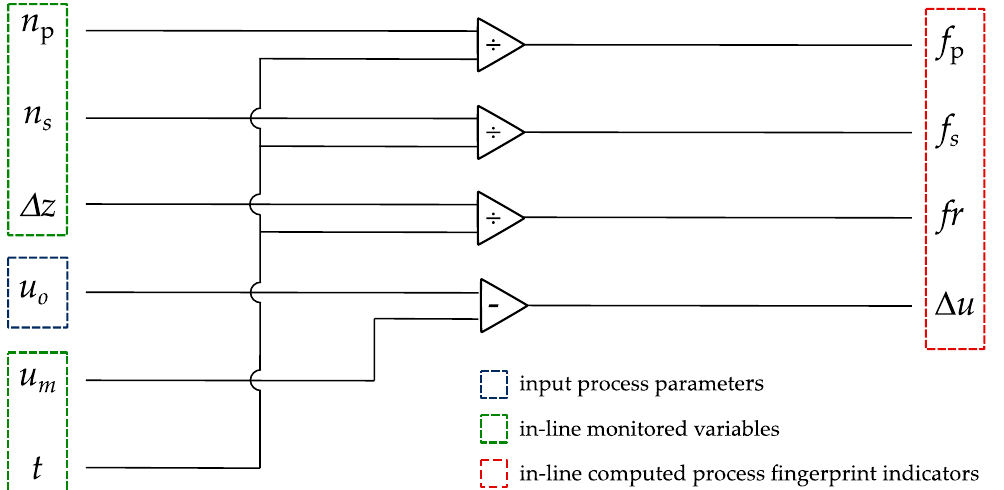
Figure 3. In-line calculation of the four quantities that are investigated as potential indicators for the process fingerprint of the micro electrical discharge machining (micro-EDM) drilling process ( n p : Number of normal discharge pulses, n s : Number of short circuits and arcs, u o : Open voltage, u m : Average gap voltage, ∆ z : Nominal drilling depth, t : Drilling time, f p : Frequency of normal discharge pulses, f s : Frequency of short circuits and arcs, fr : Feed rate, ∆ u : Differential voltage).